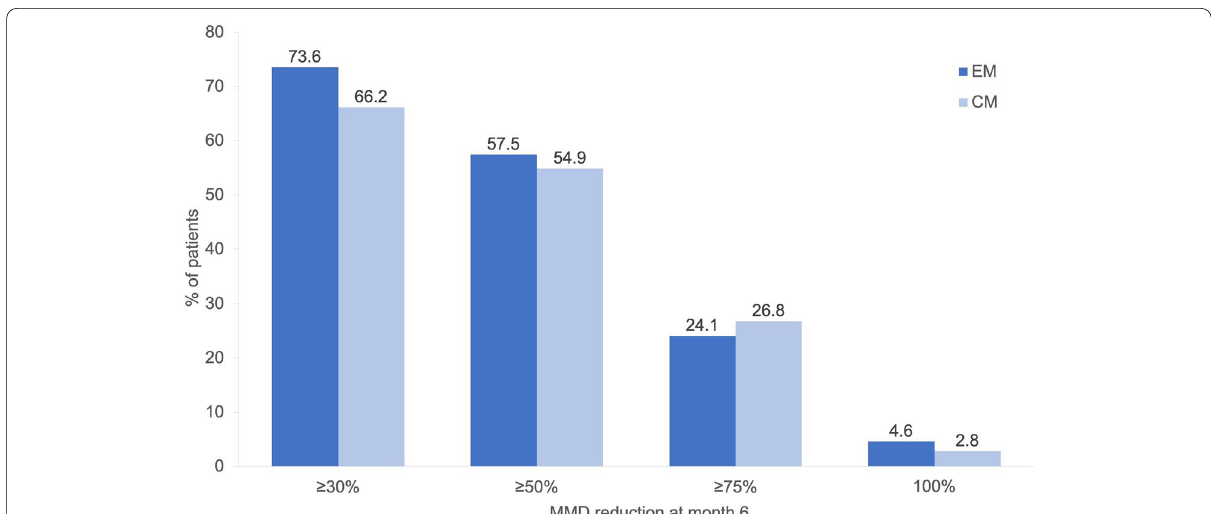
Table 3 Patients with medication days Acute Migraine‑Specific Medication